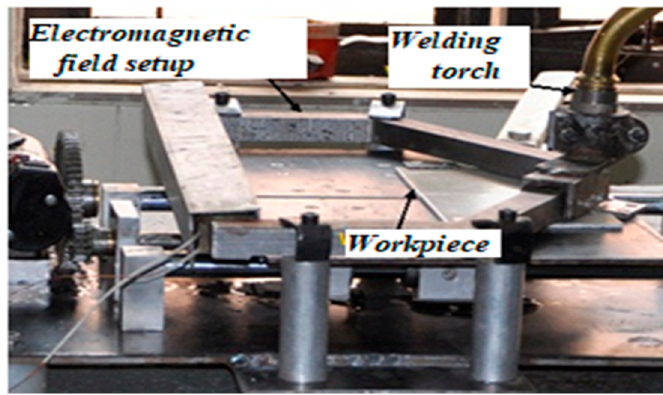
Figure 2. Schematic of the experimental setup [10].